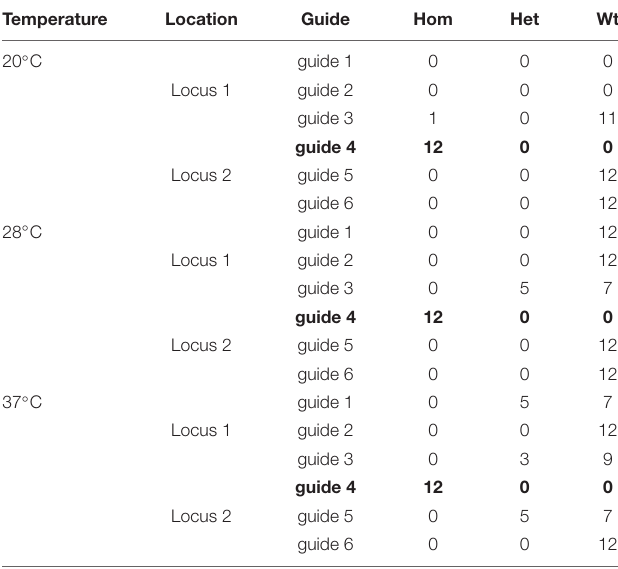
TABLE 3 | Additional mutations identified in 12 AK38.12 T1 lines grown at each of three different temperatures and assayed for novel mutations at guides targeting downstream of locus 1 (TraesCS7A02G014100) and locus 2 (TraesCS7A02G146100). Temperature